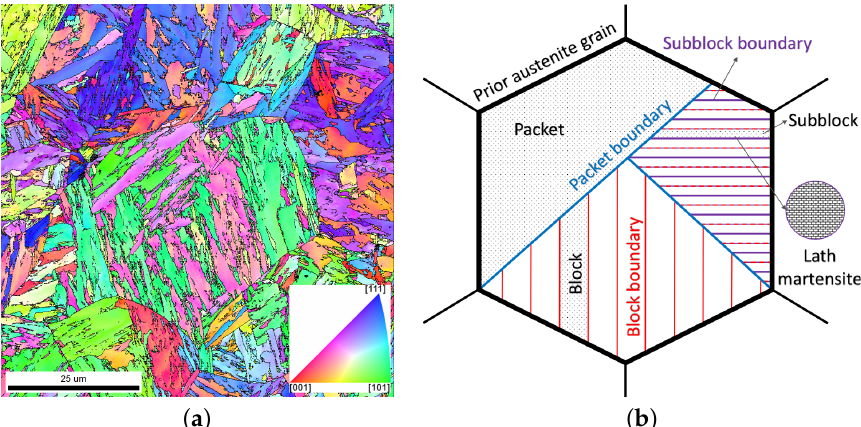
Figure 1. ( a ) Map of the Inverse Pole Figure (IPF) along the normal/out-of-plane direction of a Fe-0.13C-5.1Ni (wt%) model alloy. The heat treatment consisted of austenization at 900° for 5 min and subsequently quenching in water to obtain a fully martensitic microstructure [17]. ( b ) Schematic of the hierarchical microstructure of lath martensite.